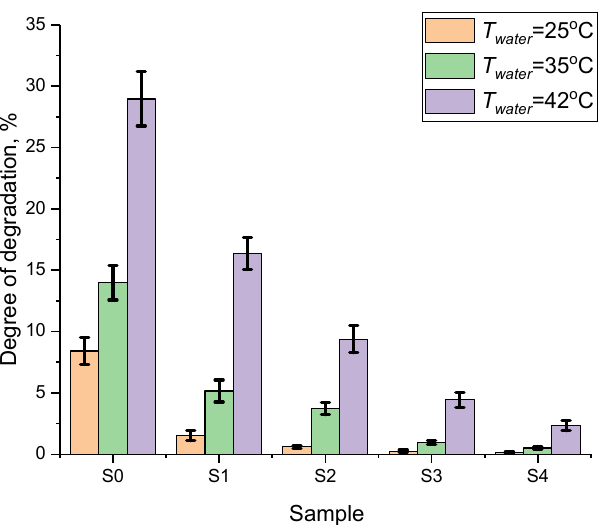
Figure 13. Data on the change in the degradation degree of the studied nanoparticles depending on the temperature of the medium.